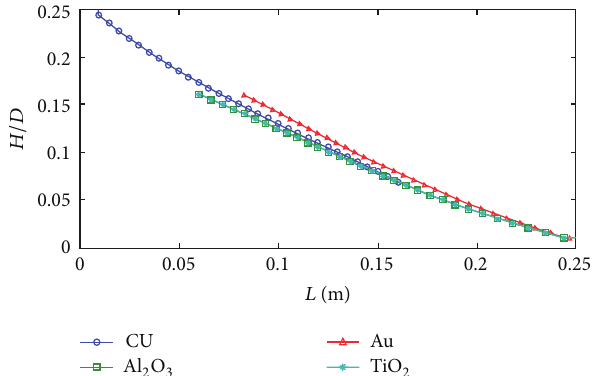
Figure 10: Variation of liquid film thickness against the pipe length for all nanoparticles.